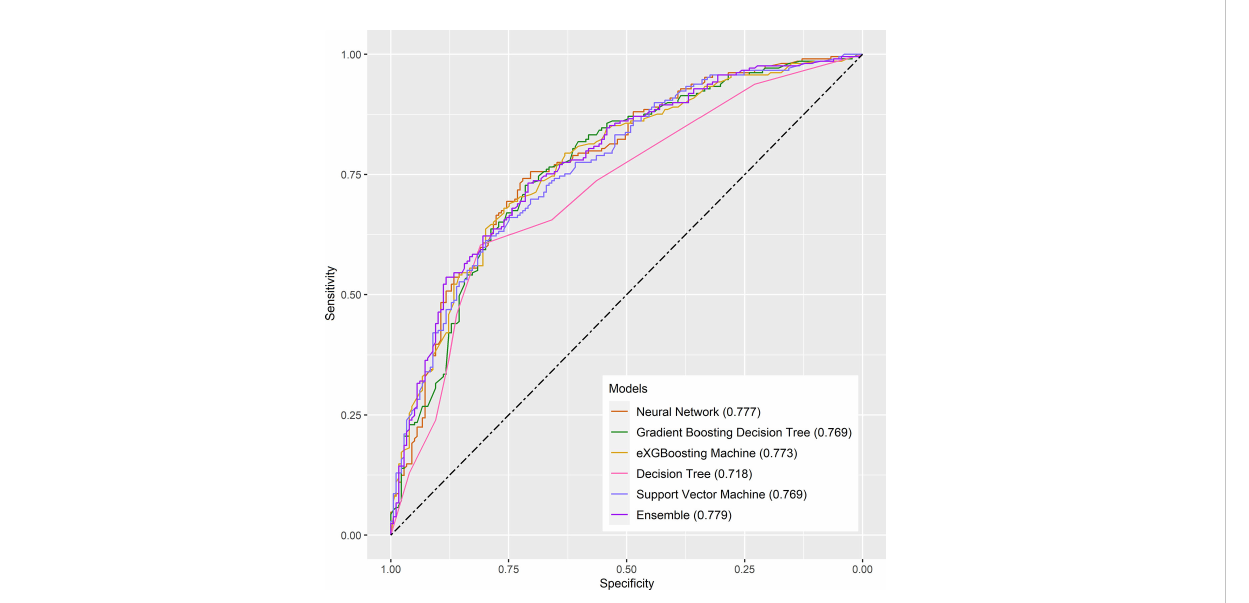
FIGURE 2 The receiver operating characteristic curves for the machine learning models in the internal testing cohort.